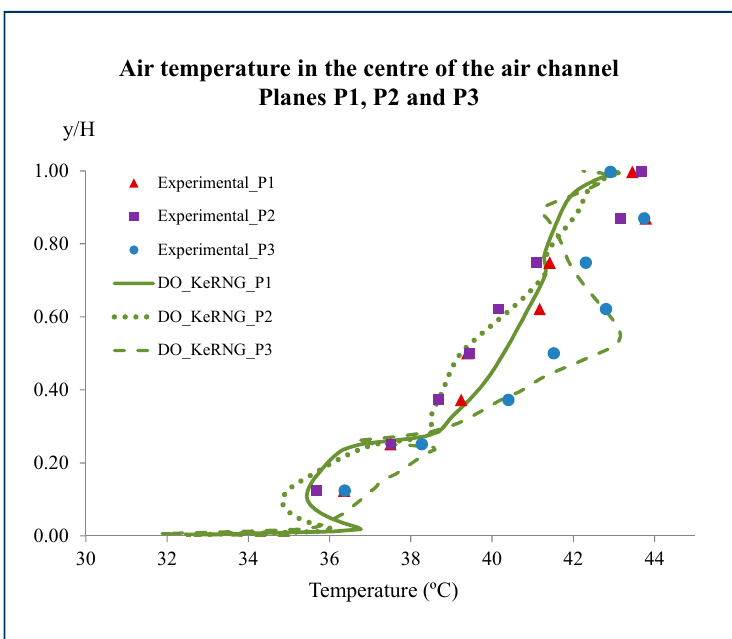
ff erent planes.